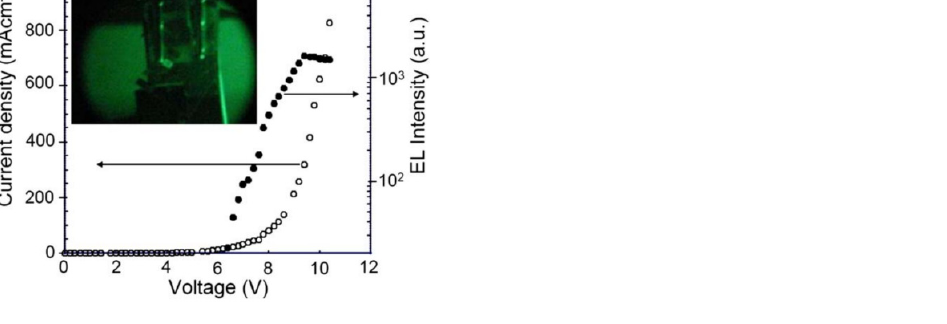
Figure 8. Current density–voltage-luminance characteristics of the M1 -based OLED device. The upper inset shows a photo of near-infrared EL obtained for the device at a drive voltage of 9.4 V, taken with an infrared scope (adapted from ref. [95]).